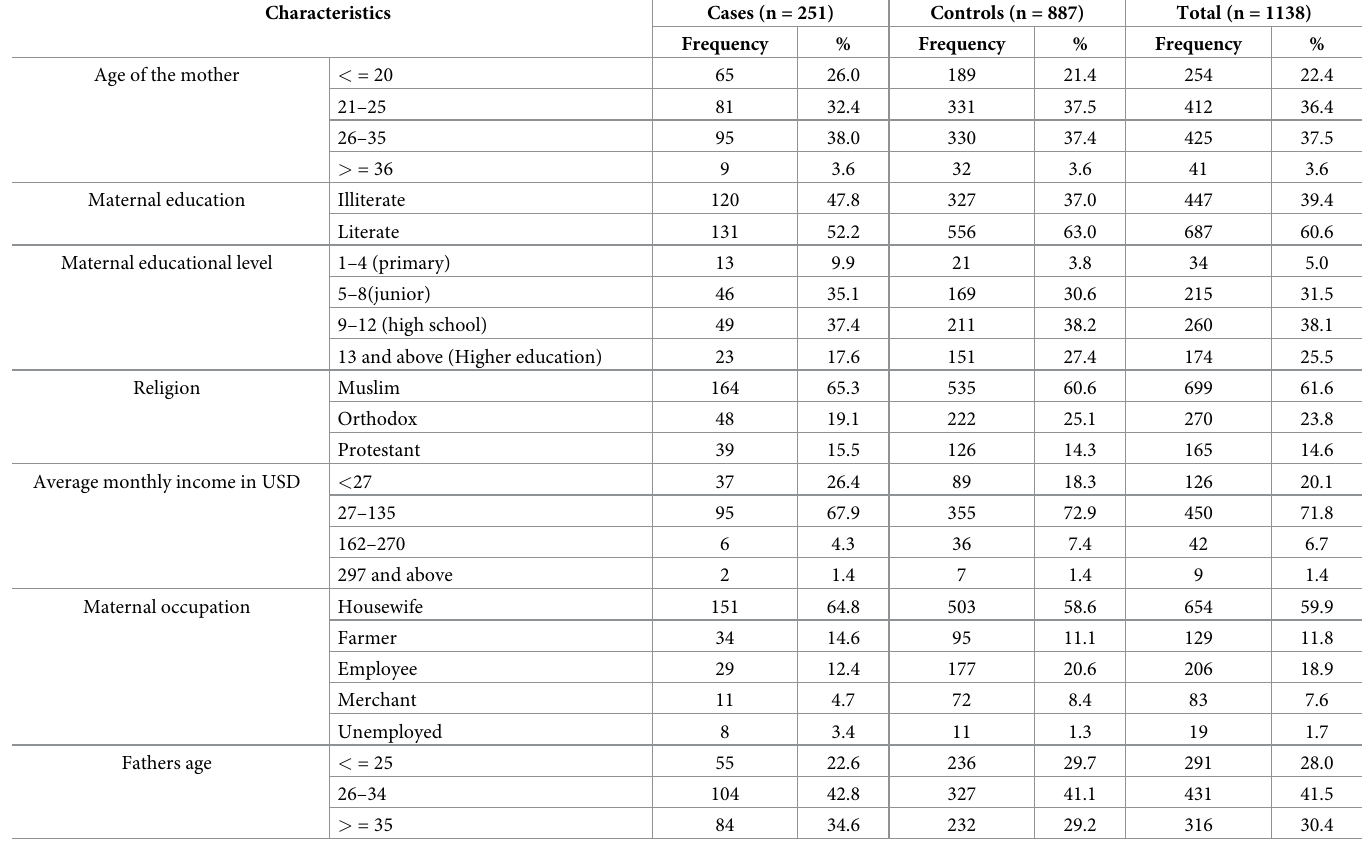
Table 2. Socio-demographic characteristics of the study subjects with or without CAs in southwestern